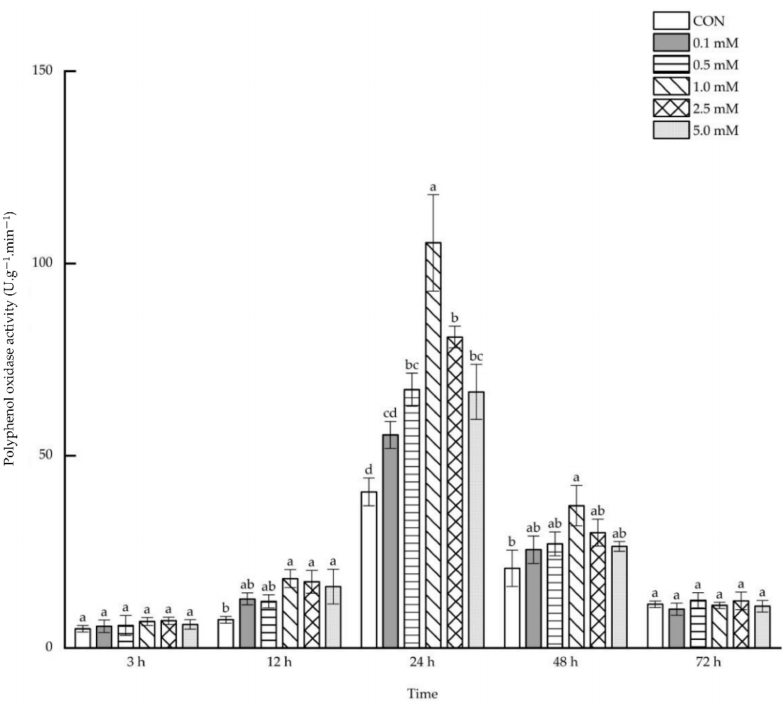
Figure 3. The direct effect of the SA concentration and post-treatment time on the polyphenol oxidase activity in leaves following exogenous foliar application. The data are presented as mean ± standard errors. The significance of data was determined by the Duncan method. The difference between different letters at the same time reached significant levels of 5%.